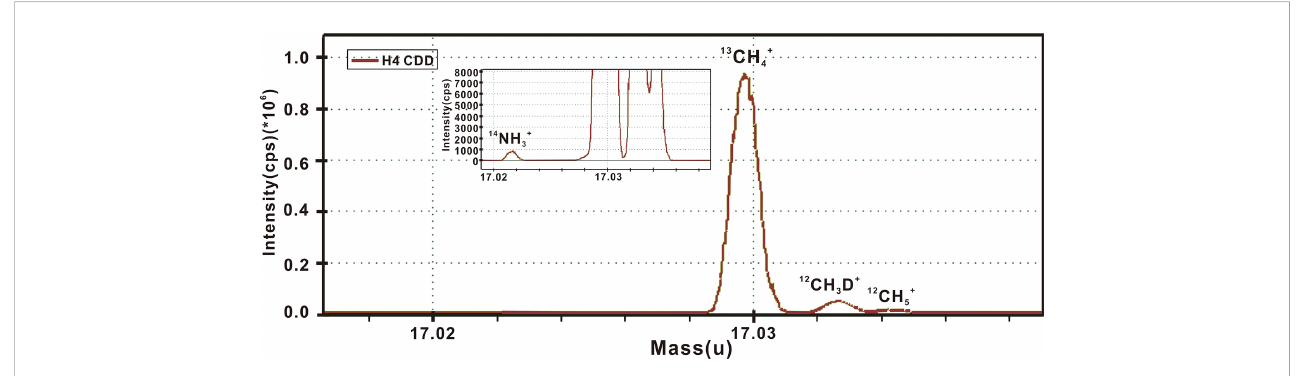
(Table 8). The average values were -0.01 ± 0.07 ‰ (1SD, n=5) for d 13 C, 0.06 ± 0.25 ‰ (1SD, n=5) for d D, and 0.21 ± 0.57 ‰ (1SD, n=5) for d 13 CH D 13 CH ‰ (1SD, 3 D (see Table 9). An average 3 D (wg) of 0.16 ± 0.52 n=5) was displayed on in-house standard methane during seven months of measurement. Due to the arrangement of other experiments, such as heated gas, and natural gas samples analysis, the quantity of D 13 CH 3 D (wg) data on in-house standard methane is not suf fi cient. The external precision ( ± 0.52 ‰ ) of D 13 CH 3 D (wg) was larger than the data ( ± 0.35 - ± 0.41 ‰ ) reported by other laboratories (Table 8). However, because our instrument was affected by the unstable temperature and humidity in our laboratory, its resolution power was compromised, which probably overwhelm the effect of the improvement of the measurement precision of d 13 C, d D, and d 13 CH 3 D. Nevertheless, the precision would have potential to be improved if the resolution power could be further well-controlled in the future. TABLE 7 Conventional stable isotope compositions ( d 13 C VPDB and d D VSMOW ) of in-house standard methane and puri fi ed methane. Projects